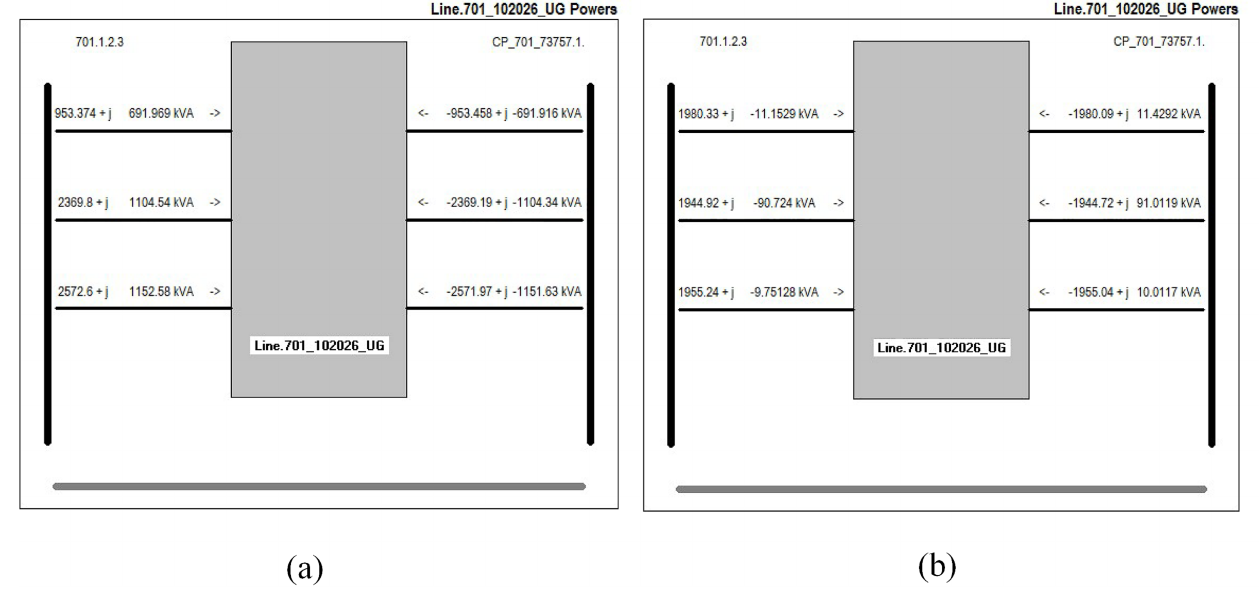
Figure 20. Substation active and reactive power flow in ( a ) base case, and ( b ) Case